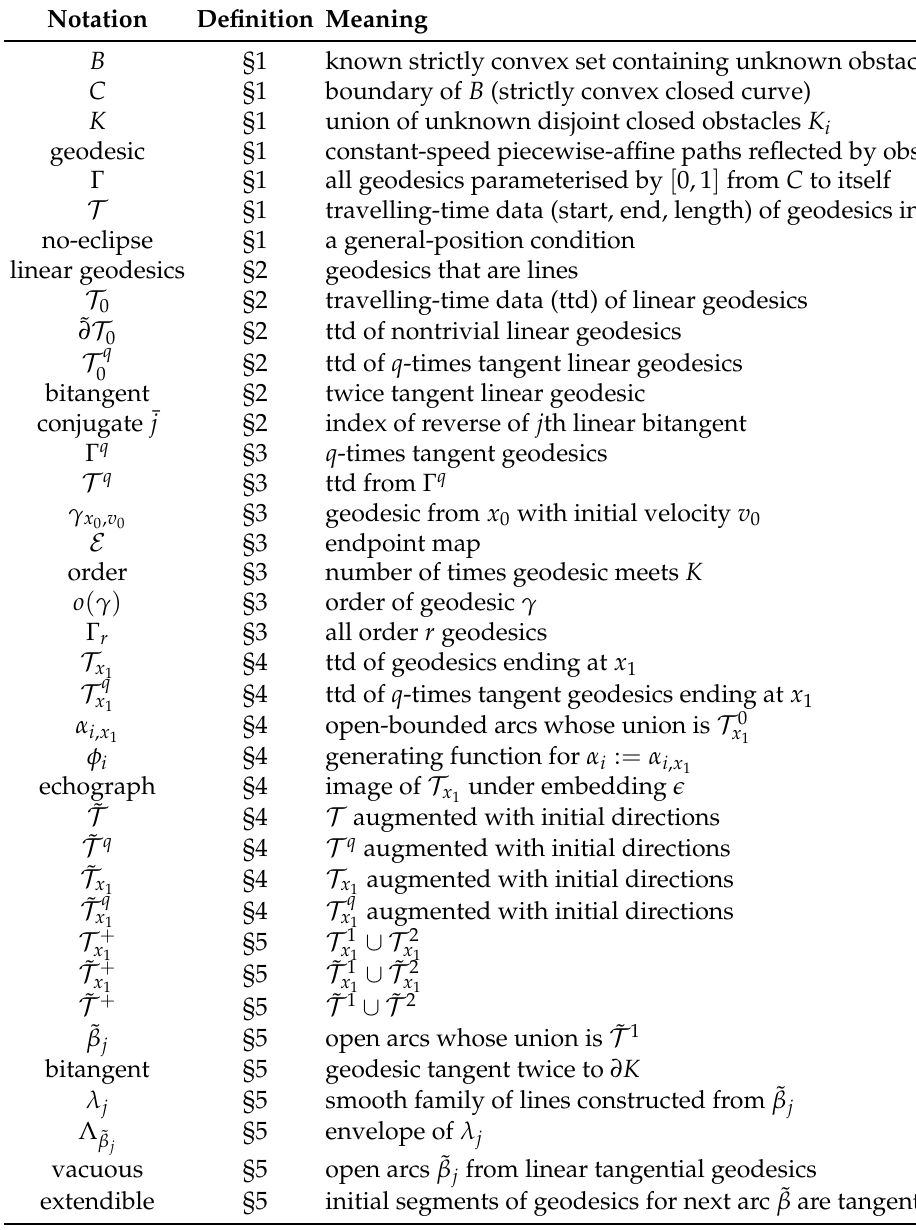
Table 1. Glossary of Terms and